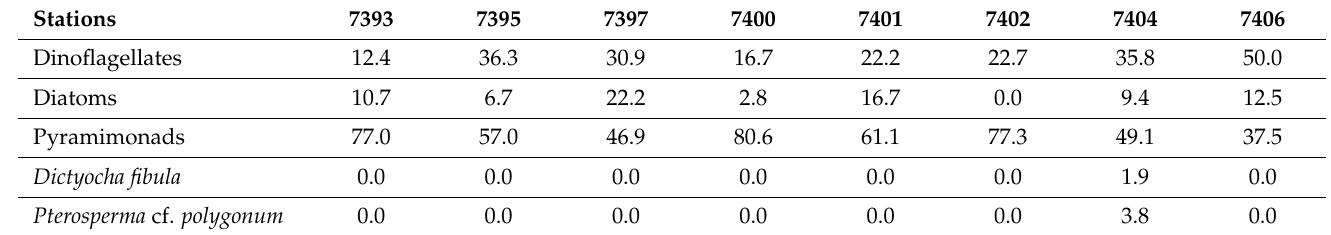
Table 3. Structure of phytoplankton communities at stations. The contributions (in % of the total number) formed by representatives of various large taxonomic groups are given. Specific species are indicated for the groups represented by one